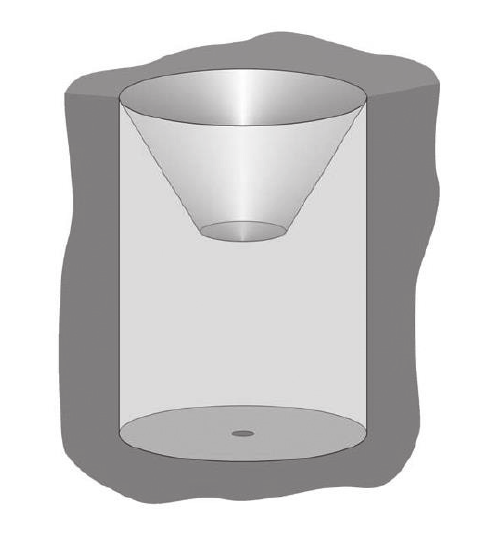
Figure 6. Pitfall traps used by Vrezec et al.